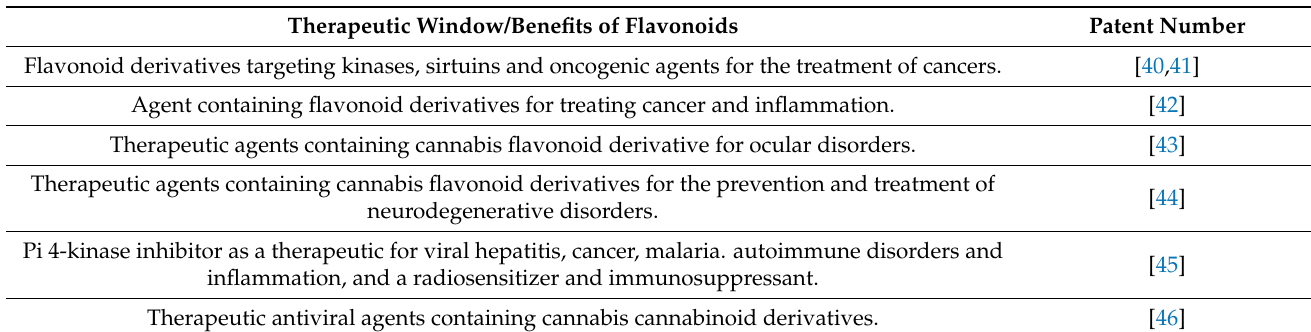
Figure 5. A comparison of the docking/binding studies results between the phytoantiviral flavonoids hesperetin, myricetin, linebacker, and caflanone [39]. Table 6. More therapeutic benefits of